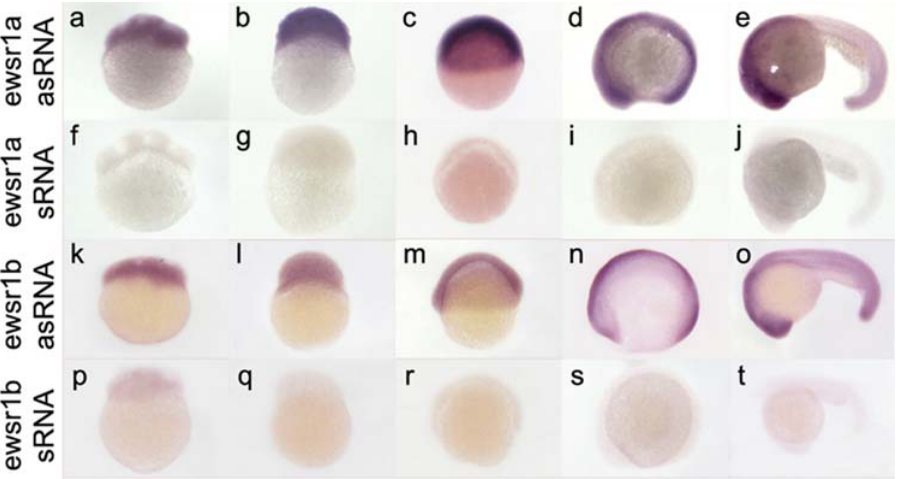
Figure 2. Initial Maternal and Subsequent Ubiquitious Expression of ewsr1aand ewsr1bmRNAs in Zebrafish Embryonic Development. The images are lateral views of embryos stained by in situ hybridization using anti-sense RNA (a–e, k-o) or sense RNA (f–j, p–t) for ewsr1a and ewsr1b . The ewsr1a and ewsr1b were expressed ubiquitously at 4 cell (a and k), 256 cell (b and l), shield (c and m), 5 somite stage (d and s) and 24hpf (e and t). asRNA: anti-sense RNA, sRNA: sense